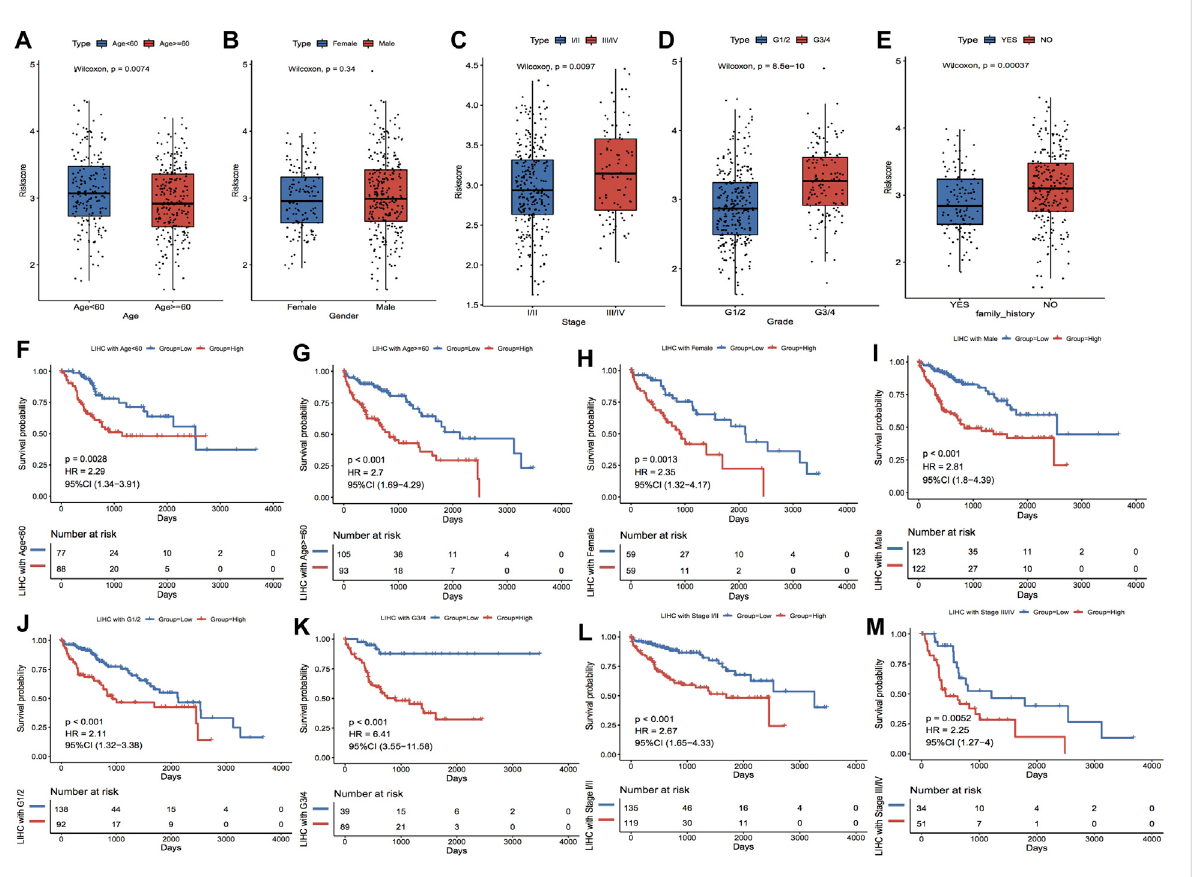
FIGURE 8 Clinical characteristics correlated with model scores. (A – E) show the distributions of Riskscore in the clinical characteristics grouping, corresponding to age, gender, stage, grade and family history, respectively. (F – M) show the subgroups of Age, Gender, Grade and Stage characteristics, respectively. In the KM curves of the dataset, red highlights the high-risk group and blue highlights the low-risk